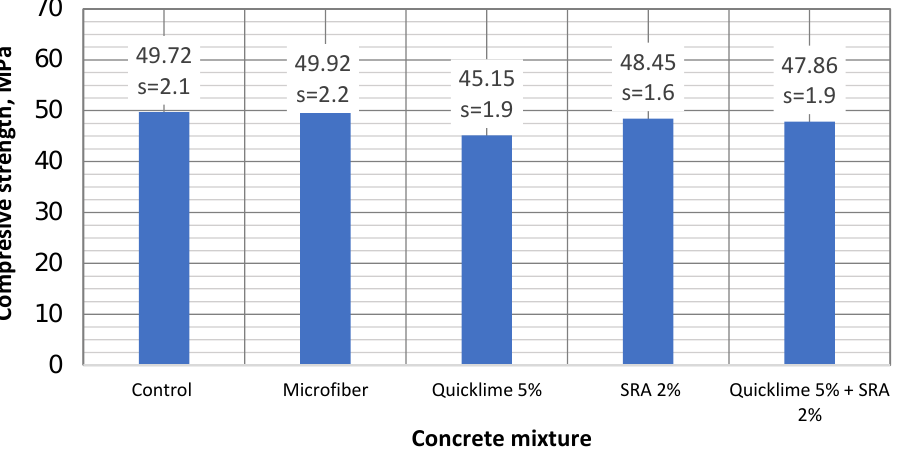
Figure 4. The compressive strength results of various concrete compositions.